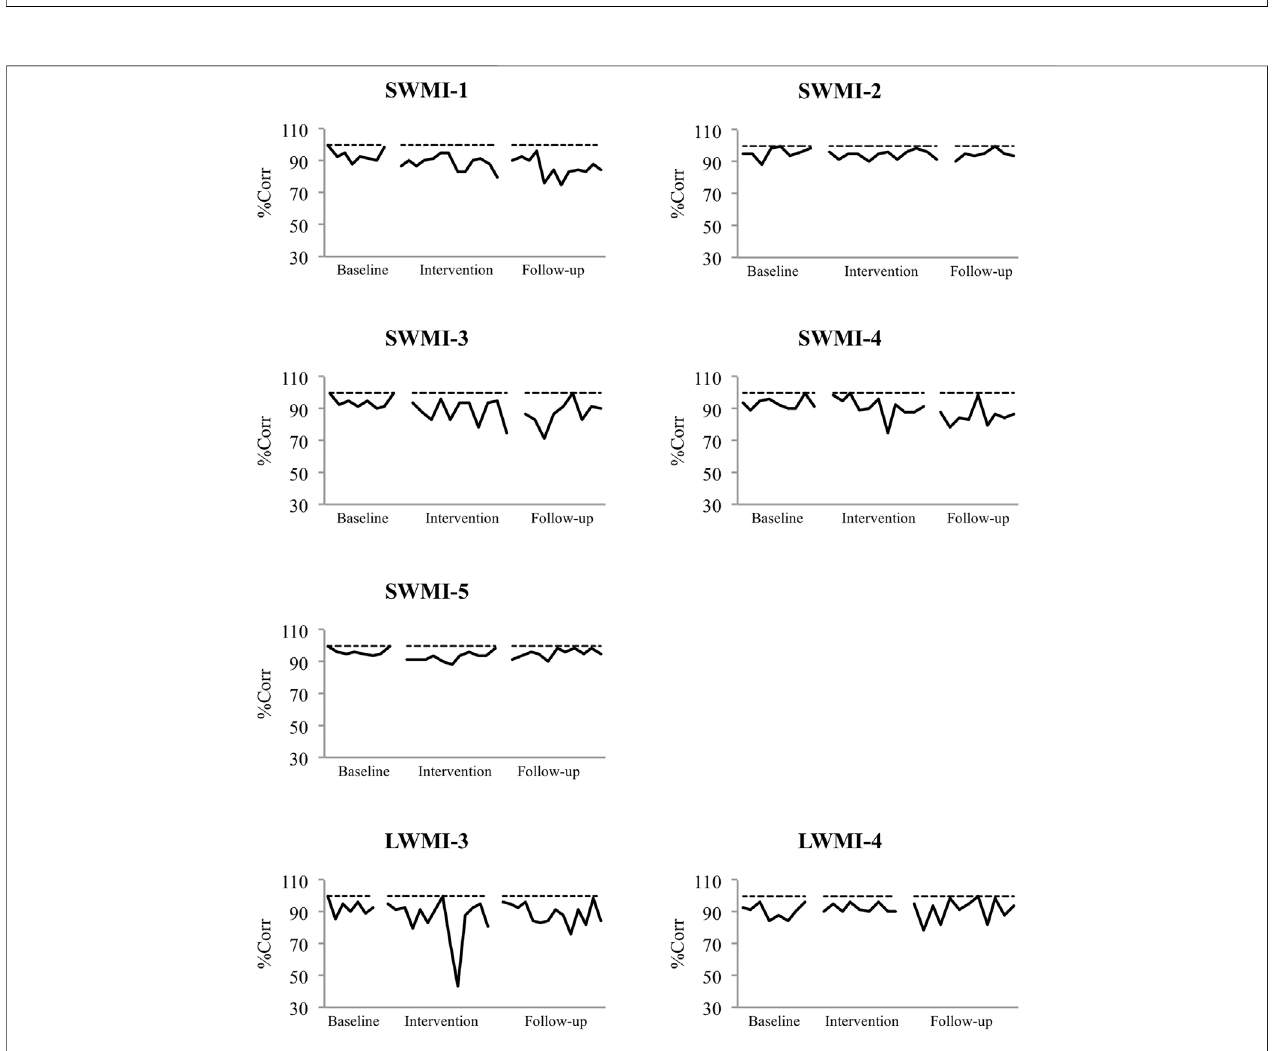
FIGURE7| NumberComparison probe. Graphspresent percent items correctfrom each session. Dashed lineindicates 100%items correct inplace of2 SD limit.